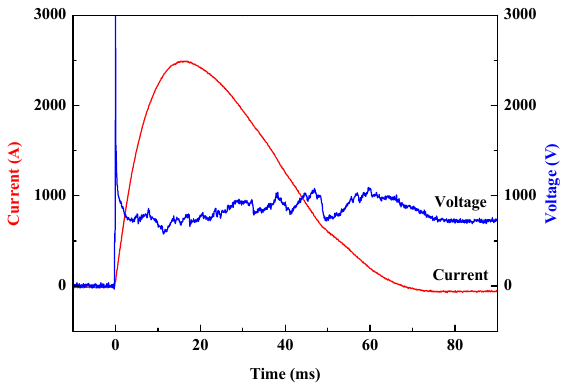
Figure 4. Typical current and voltage waveforms of a free burning arc.